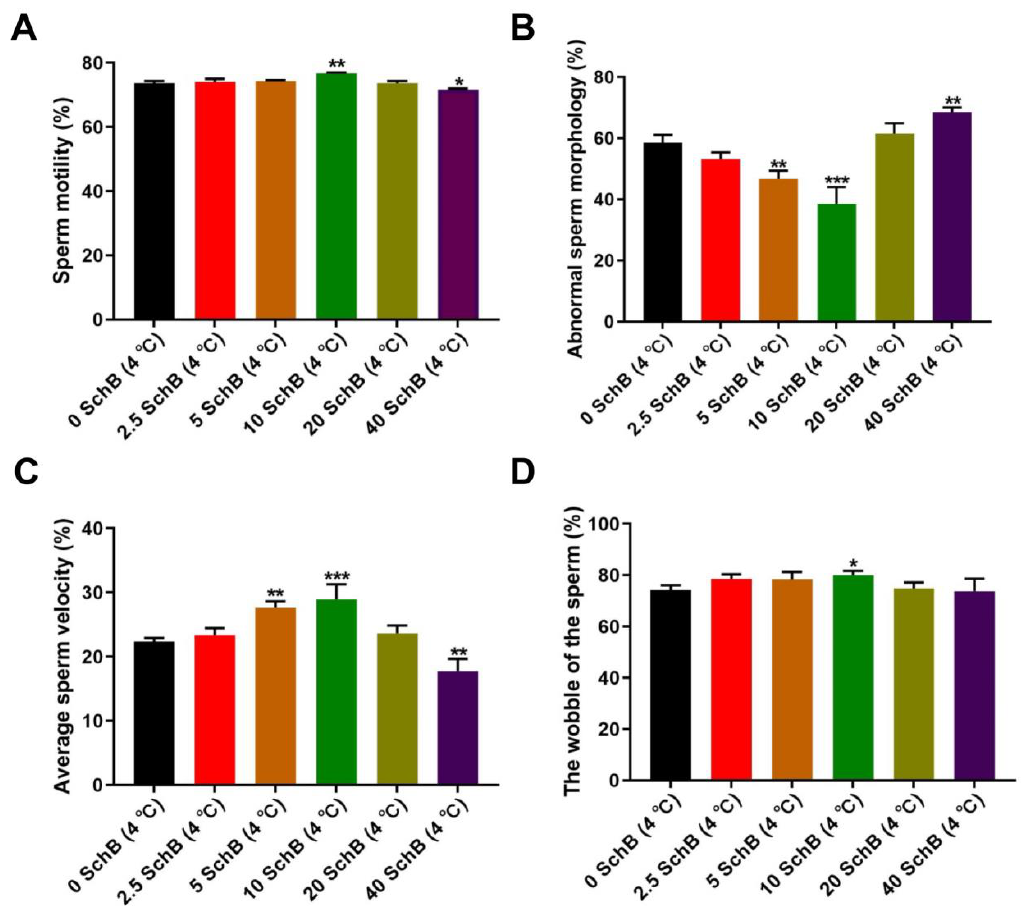
Figure 1. ( A – D ): Effect of Sch B on the motility, abnormal sperm morphology, average movement velocity and wobbility of boar sperm: ( A ) Sperm motility. ( B ) abnormal sperm morphology ( C ) Average movement velocity. ( D ) Sperm wobbility. Data are expressed as mean ± SD ( n = 12). *** p < 0.001, ** p < 0.01 and * p < 0.05 vs. 0 Sch B. The differences in abnormal sperm morphology are shown in Figure 1B. Compared to 0 Sch B, 5 Sch B and 10 Sch B significantly decreased the abnormal sperm morphology level in a dose-dependent manner. On the contrary, 40 Sch B significantly increased the abnormal sperm morphology level compared with 0 Sch B.